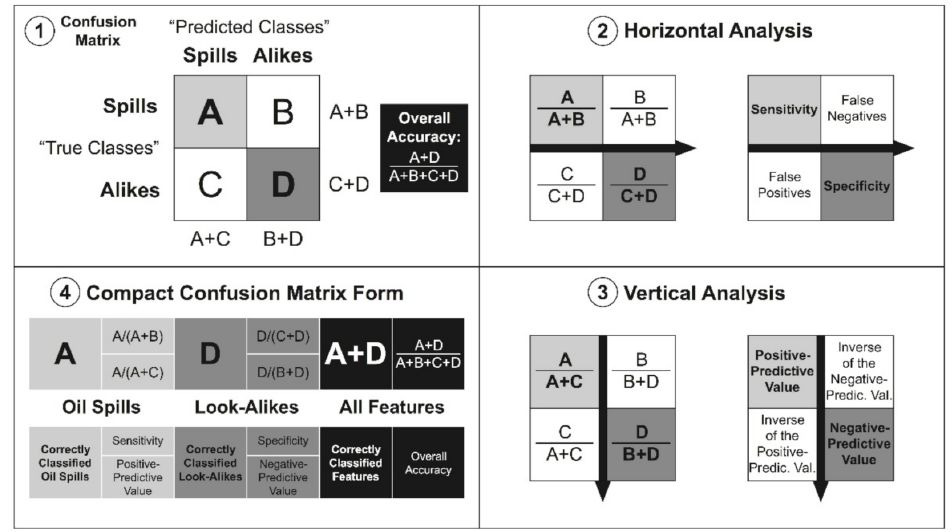
Figure 4. Confusion matrix, i.e., 2-by-2 table (panel 1): “Predicted classes”: algorithm outcome. “True classes”: expert interpretation. ( A ) Correctly classified oil spills. ( B ) Misidentified oil spills. ( C ) Misidentified look-alike slicks. ( D ) Correctly classified look-alike slicks. Number of correctly classified features: A + D . A priori known oil spills ( A + B ) and look-alikes ( C + D )—these are fixed values established in the data-filtering scheme. Numbers of classified oil spills ( A + C ) and look- alikes ( B + D ) differ for each algorithm. Performance metrics: overall accuracy (panel 1), sensitivity and specificity (panel 2: horizontal analysis), and positive- and negative-predictive values (panel 3: vertical analysis). Compact confusion matrix form (panel 4) used to facilitate the comparison of the many explored classifiers: 114—i.e., 60 (Figure 3) plus 54 (Table 1). See also Section